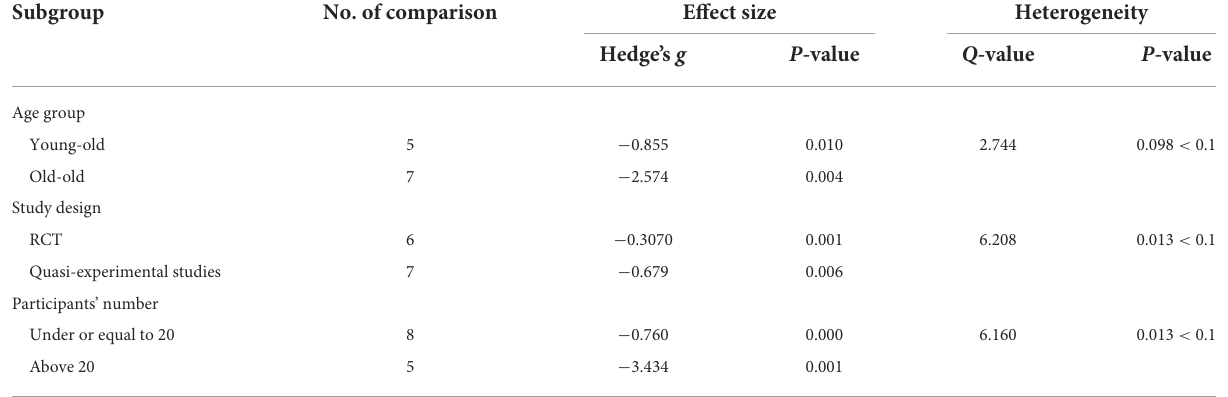
TABLE 1 Summary of the meta-analysis for six